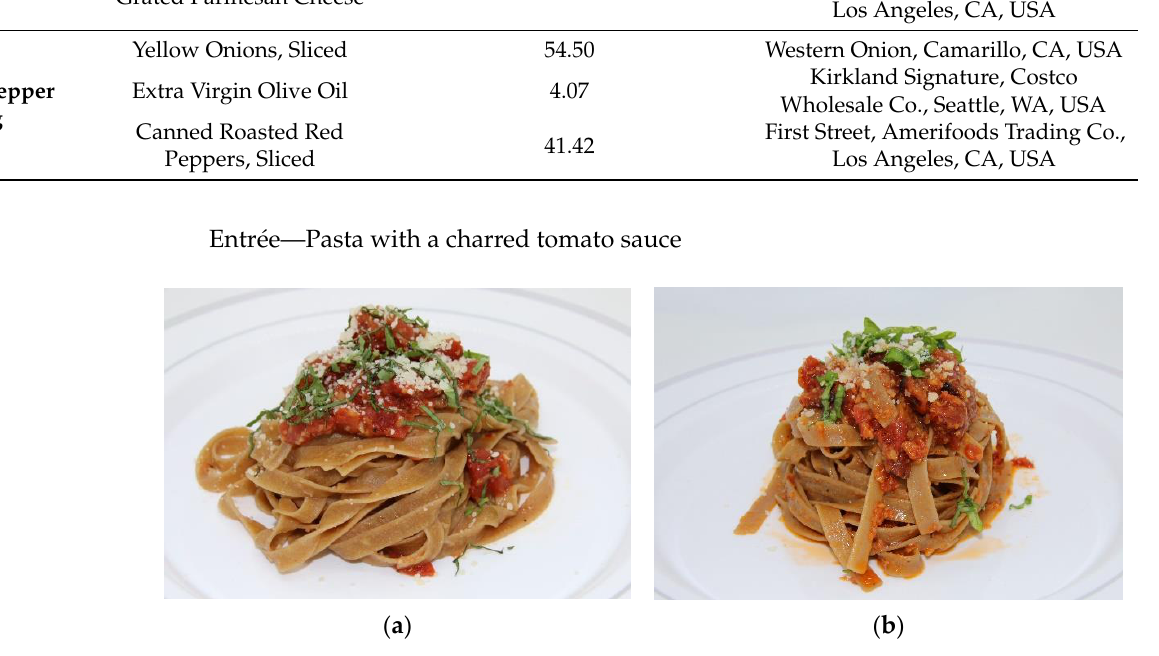
Figure A2. Pasta entrée presented to participants for product evaluation. ( a ) Pasta dish containing the Control pasta used in the study and ( b ) the pasta dish containing the CP pasta. Table A2. Ingredients used and their sources for the pasta entrée. The pasta component shows the formulations for both the Control and CP versions. Usage levels (%) shown are the percentages used for each dish component. Percentages were rounded to the nearest hundredths.